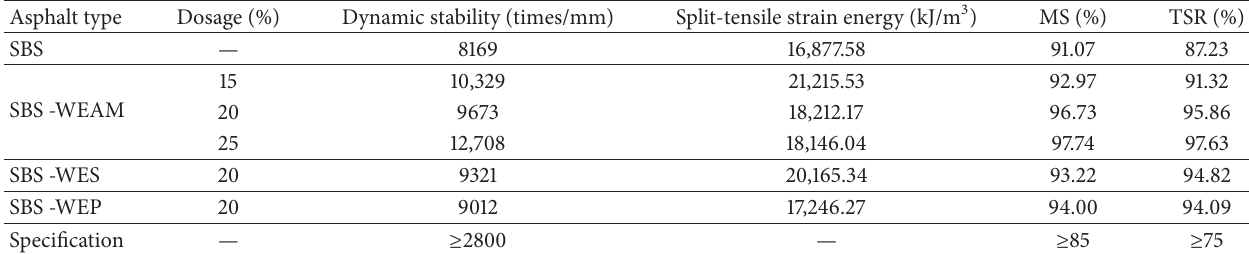
Table 5: Road performance and various modified asphalt